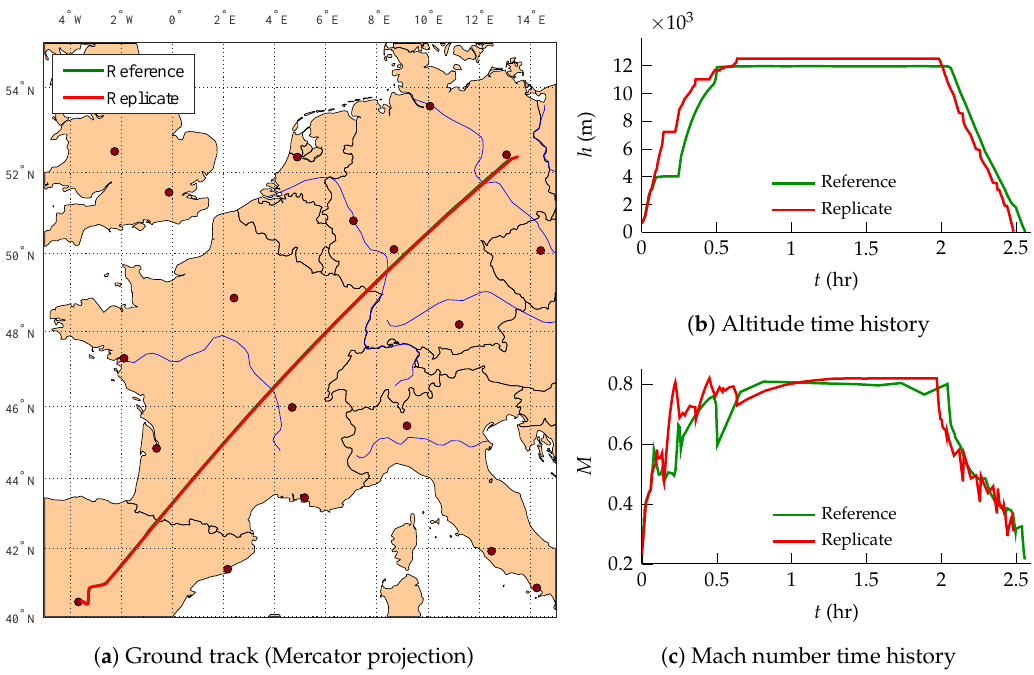
Figure 6. Comparison between the reference and replicate missions ( a ) ground tracks, ( b ) altitude time histories, and ( c ) Mach number time